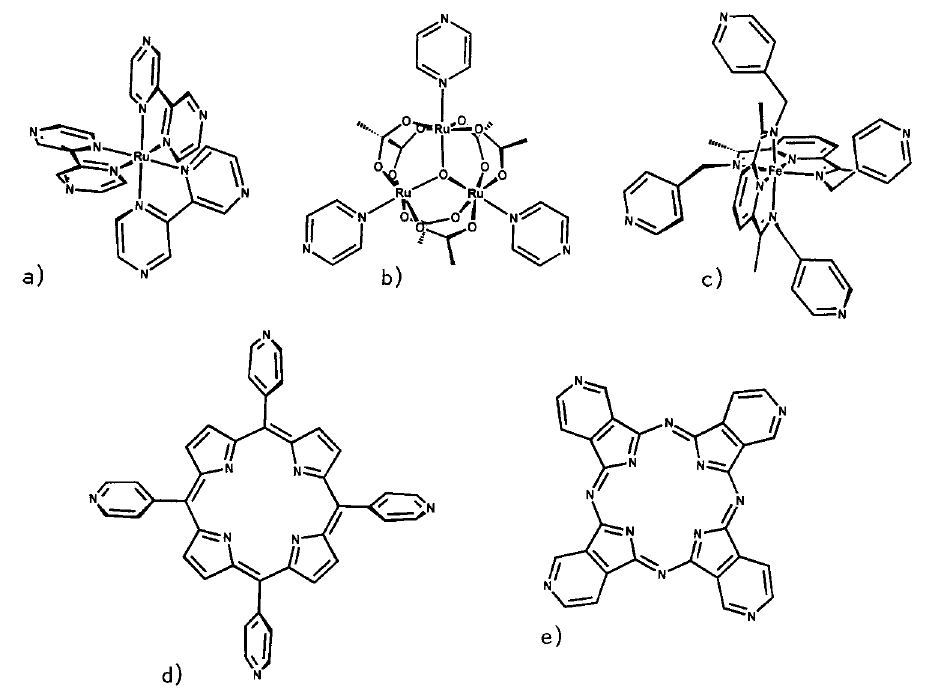
Fig. 2 – Typical metal-organic building blocks: a) [Ru(bpz) 3 ] 2 + complex (bpz = 2,2’-bipyrazine); b) [Ru 3 O(CH 3 CO 2 ) 6 (pz) 3 ] + cluster (pz = pyrazine); c) ruthenium(II) polyimine complex derived from 2,6- diacetylpyridine and 4-methylpyridine; d) meso- tetrapyridylporphyrin; e)